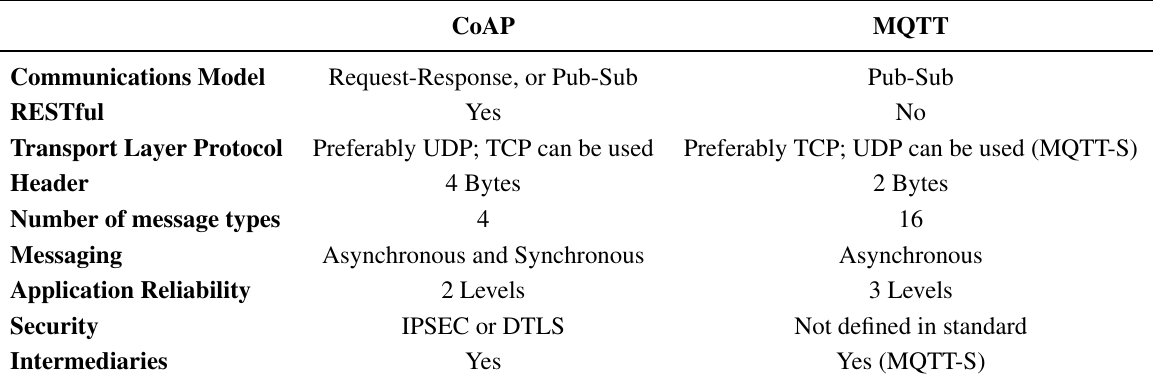
Table 2. Comparison between main features of Constrained Application Protocol (CoAP) and Message Queuing Telemetry Transport